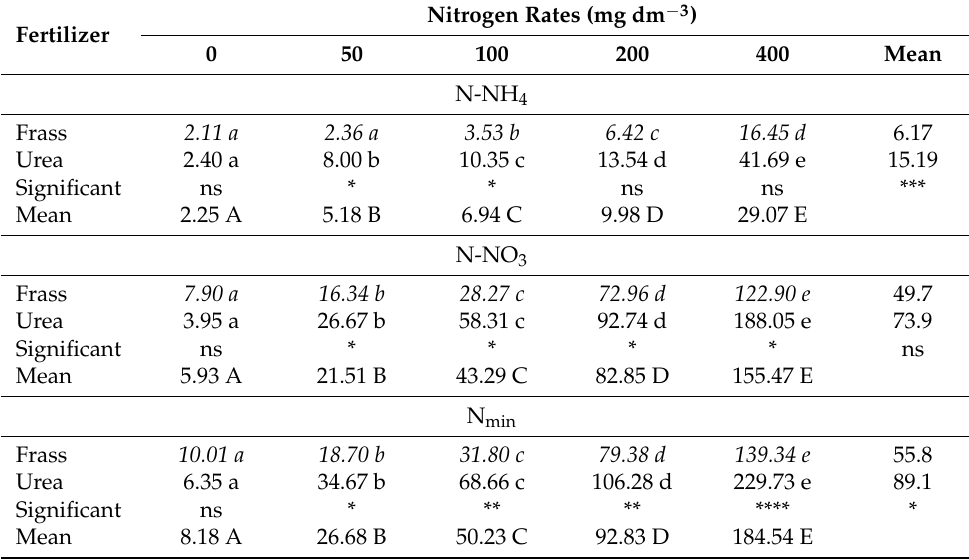
Table 1. Average content of mineral nitrogen in deacidified peat supplied with different fertilizers and nitrogen rates.